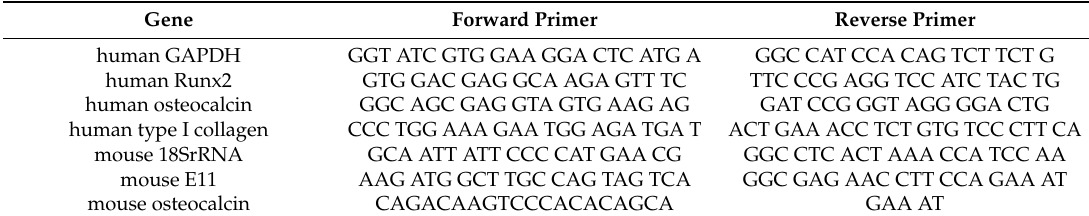
Table 1. RT-qPCR was performed to investigate relative expression levels of human GAPDH, human Runx2 and human osteocalcin in MG-63, as well as mouse 18SrRNA, mouse E11 and mouse osteocalcin in MLO-Y4. The table shows the primer sequences